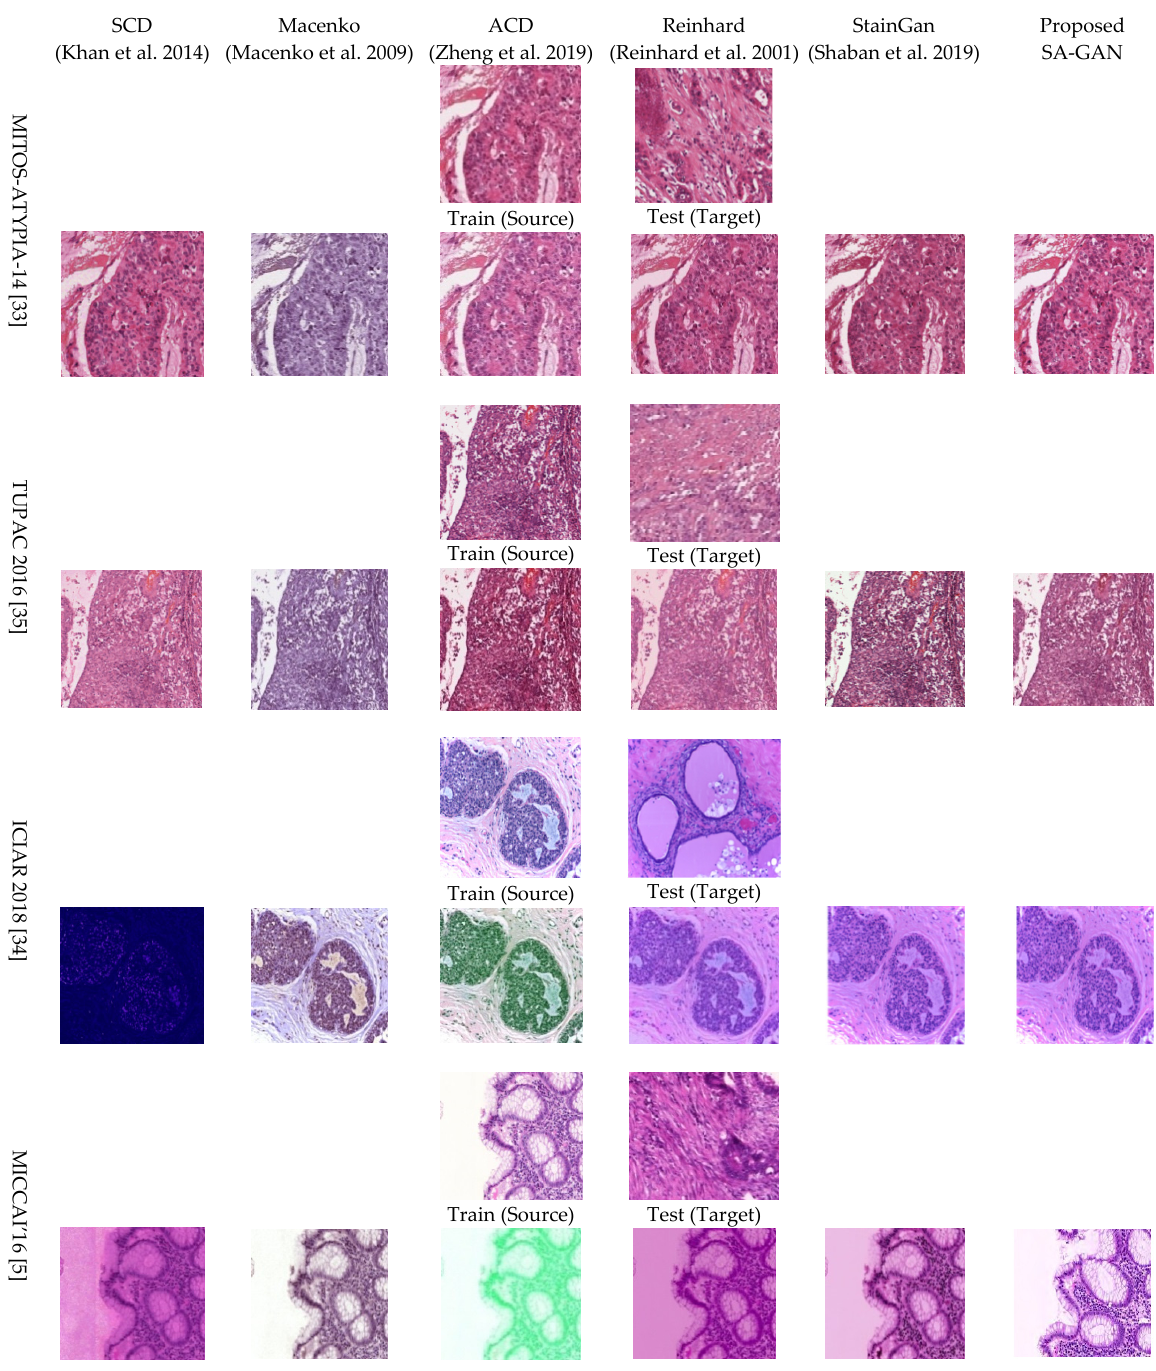
Figure 3. Visual results of color normalization algorithms SCD [16], Macenko [20], ACD [26], Rein- hard [17], StainGan [28] and Proposed SA-GAN on MITOS-ATYPIA-14 [33], TUPAC 2016 [35], ICIAR 2018 [34], MICCAI’16 [5] datasets. “Source” corresponds randomly selected original training images; “Target” corresponds to original test image chosen from various datasets. Normalized images ob- tained with the proposed method are given in the last column. Proposed SA-GAN involves color distributions of entire image domain rather to rely on single